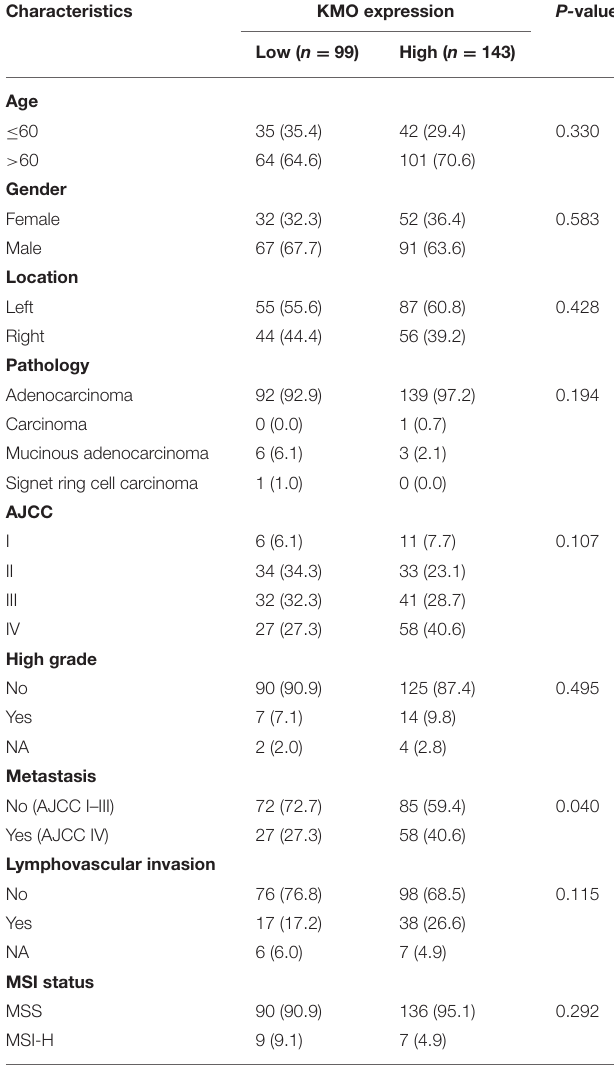
TABLE 1 | Relationship of KMO expression with CRC clinicopathological